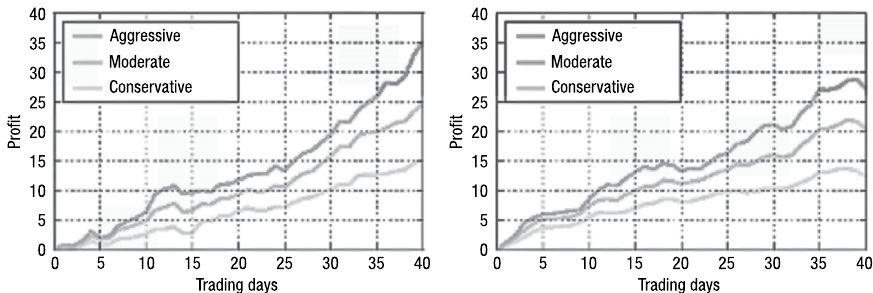
Fig. 4. The percentage of profit growth in two different